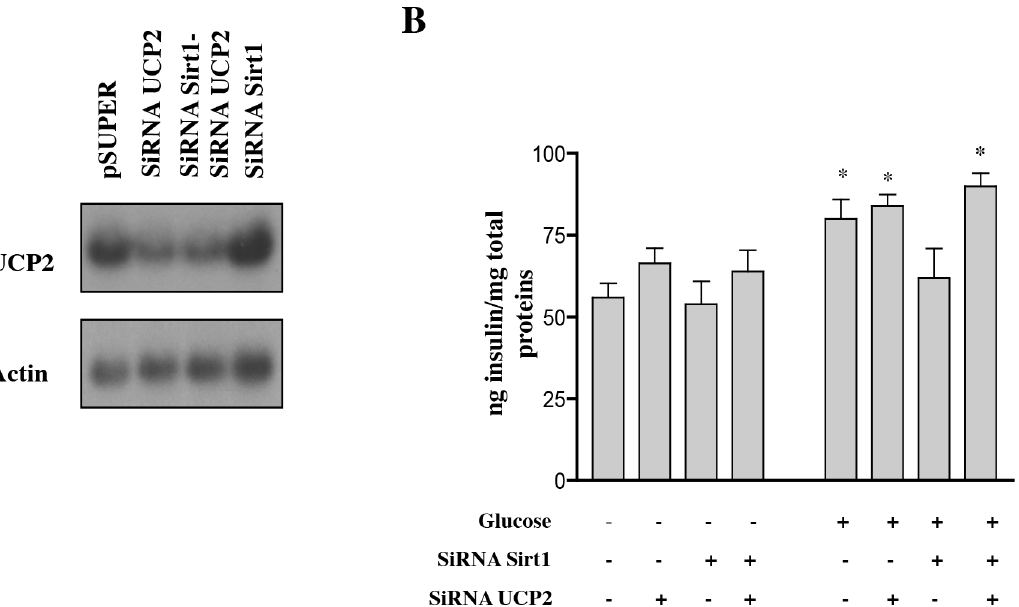
Fig 6. Knockdown of UCP2 in Sirt1 Knockdown Cells Restores Glucose-Induced Insulin Secretion. (A) Northern blot for UCP2 RNA in control INS-1 cells, and cells knocked down for Sirt1 (SiRNA Sirt1), UCP2 (SiRNA UCP2), or both Sirt1 and UCP2 (SiRNA Sirt1-SiRNA UCP2). (B) Insulin secretion in INS- 1 control cells and cells with knockdown levels of Sirt1, UCP2, or both Sirt1 and UCP2 after treatment with 16.7 mM glucose (+) or 4mM glucose ( − ) for 1 h ( n = 3 experiments done in triplicate, * p < 0.05 compared to no glucose, ANOVA).